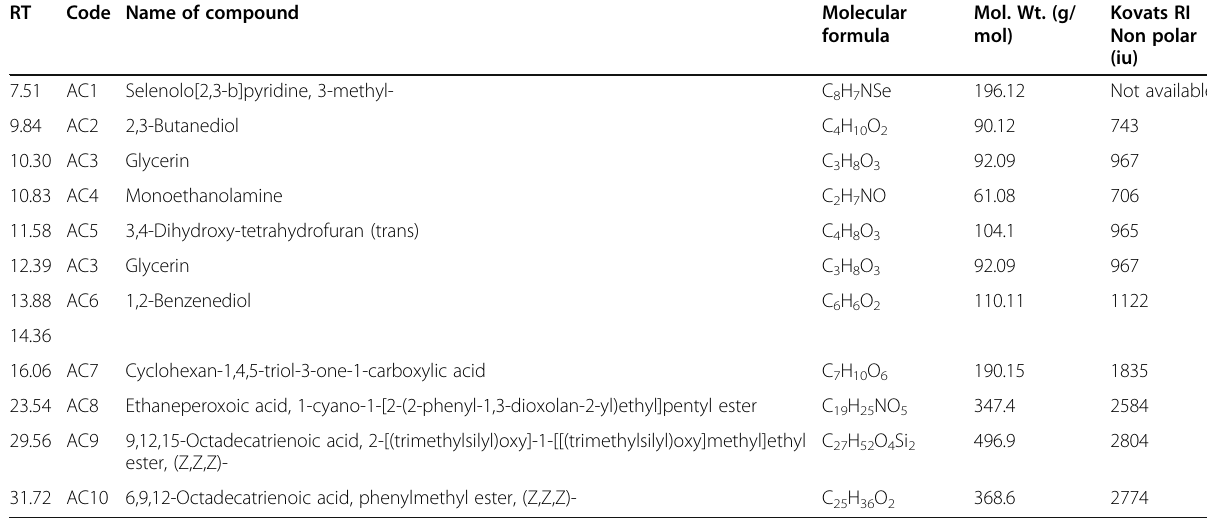
Table 2 Compounds identified in the GCMS analysis of methanol extract of fermented Allium cepa peels RT